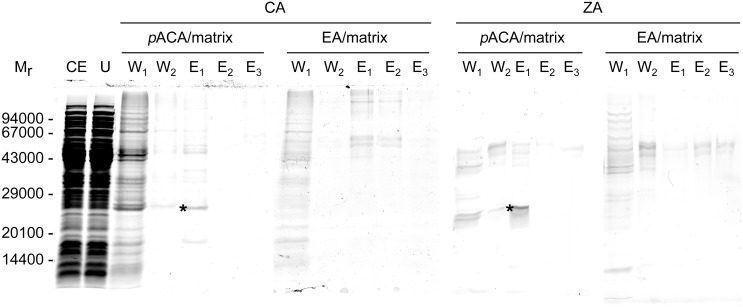
SDS-PAGE analysis of protein pull-down.Coomassie Blue stained SDS-PAGEs of representative protein-pull-down experiments carried out using sodium cinnamate (CA) or sodium zosterate (ZA) as elution competitors and matrixes functionalized (p-ACA/matrix) or not (EA/matrix) with the ZA active scaffold are reported. CE, crude extract (35 μg); U, unbound fraction (35 μg); W1, W2, washing step fractions; E1-E3, elution step fractions. The W and E samples were TCA-precipitated from 870 μL fraction aliquots. The Mrs and positions of marker proteins are reported on left side.